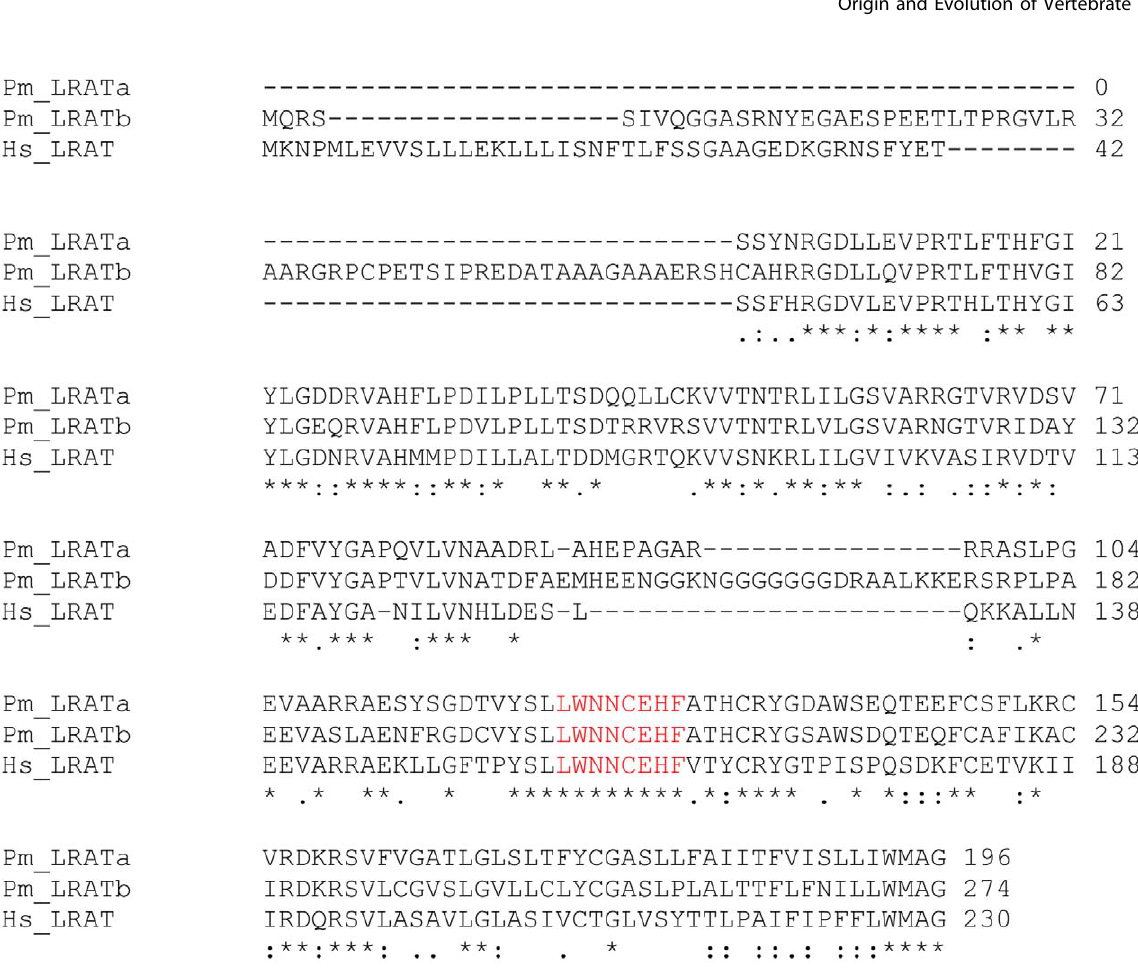
Figure 6. Alignment of Human and Lamprey LRAT sequences. CLUSTAL W (1.83) alignment of Human LRAT , Lamprey LRATa (partial sequence from contig9067, Petromyzon marinus Genome draft assembly WUSTL v.3.0 (March 2007) and Lamprey LRATb. GenBank/EBI accession numbers are as follows: human LRAT, AAH31053 , lamprey LRATb, JX115000. Asterisks, identity; double dots, strong physico-chemical similiarity; single dots, weak physico-chemical similiarity.